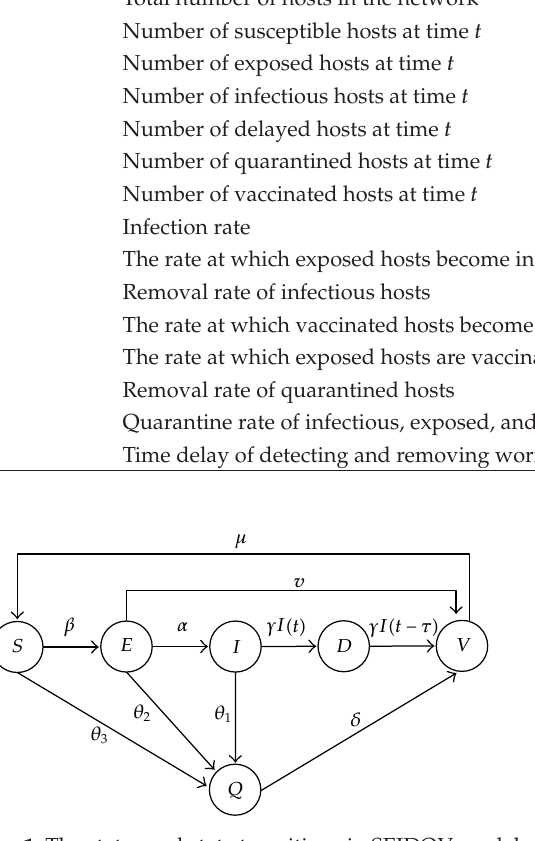
Figure 1: The states and state transitions in SEIDQV